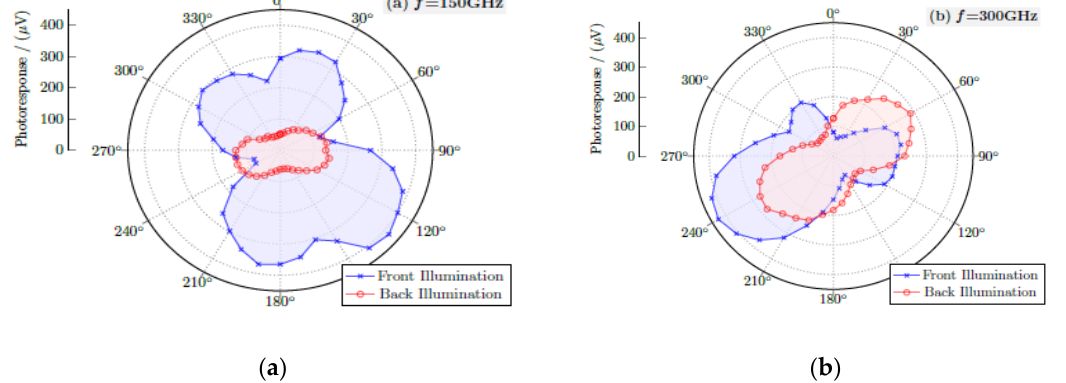
Figure 7. Photoresponse signal as a function of the rotation angle under excitation of ( a ) 0.15 THz and ( b ) 0.3 THz and for both configurations front and back illumination.